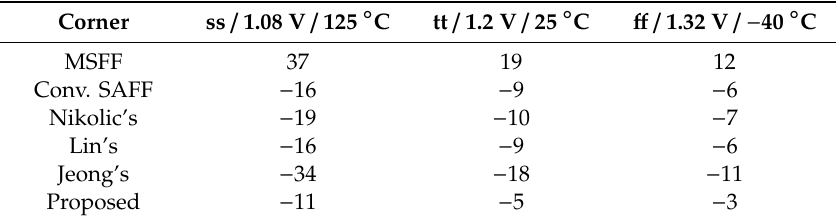
Table 4. Setup time (ps) of the flip-flops across PVT